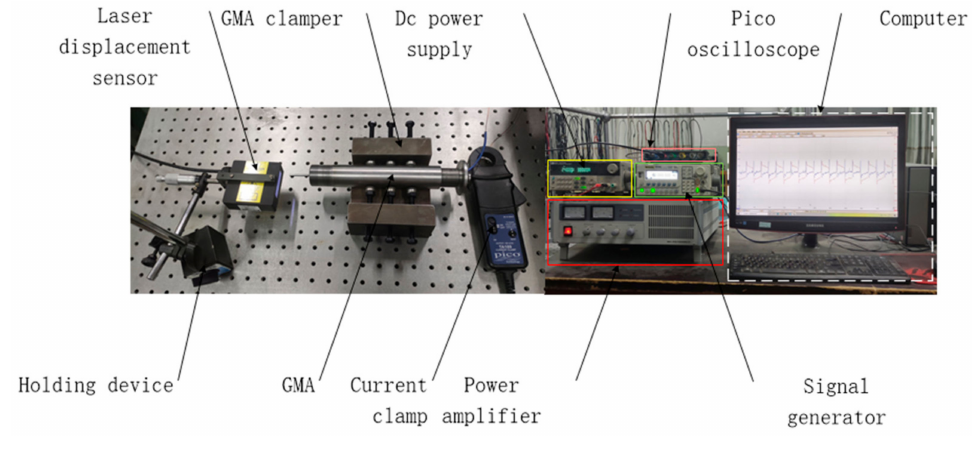
Figure 7. GMA test system’s physical diagram.